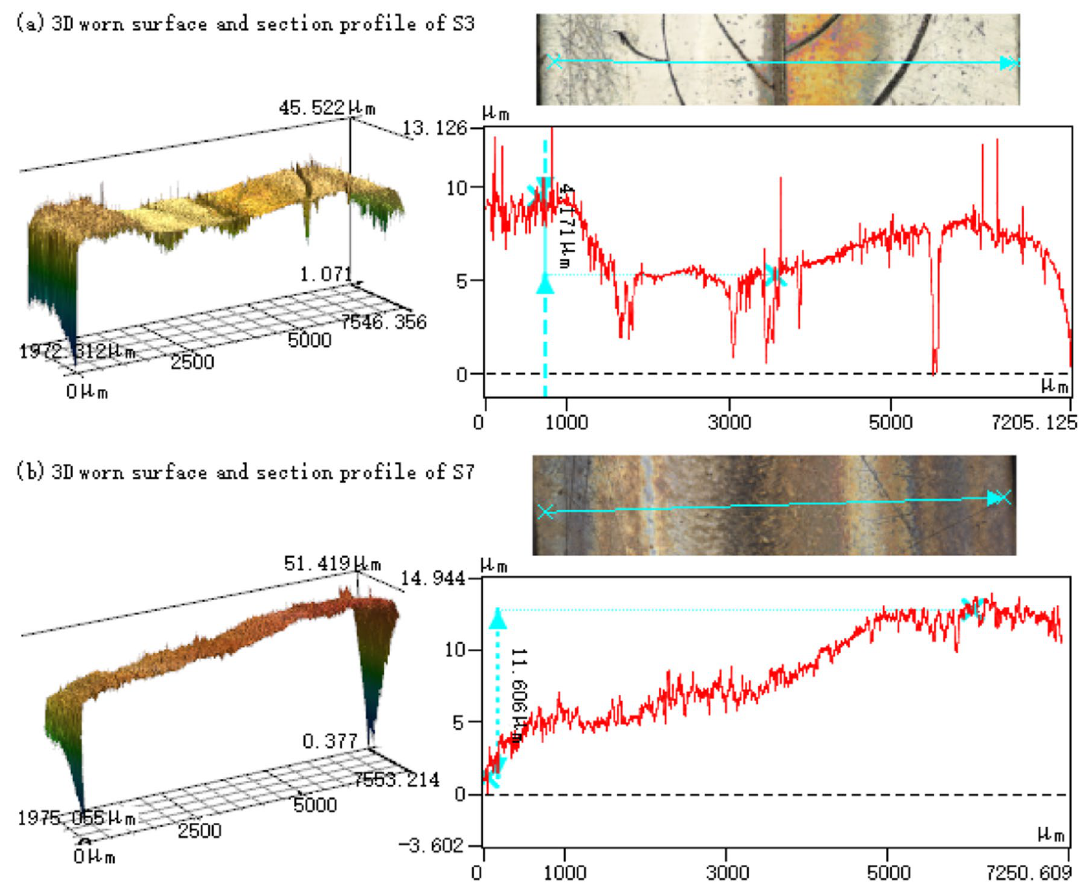
Figure 6. 3D worn surfaces and section profiles of S3 and